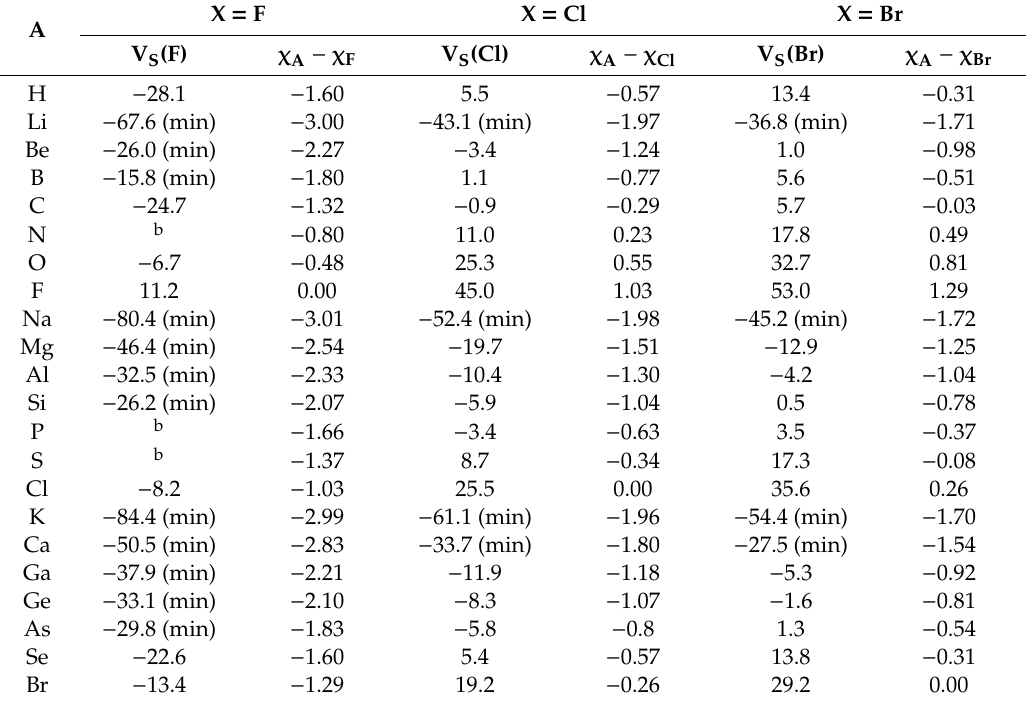
Table 3. Properties of H n A–X molecules (X = F, Cl, and Br). V S (X) is computed maximum or minimum of V S ( r ) on X, on the extension of the A–X bond. The minima are explicitly indicated. χ A − χ X is di ff erence in electronegativities of A and X a .